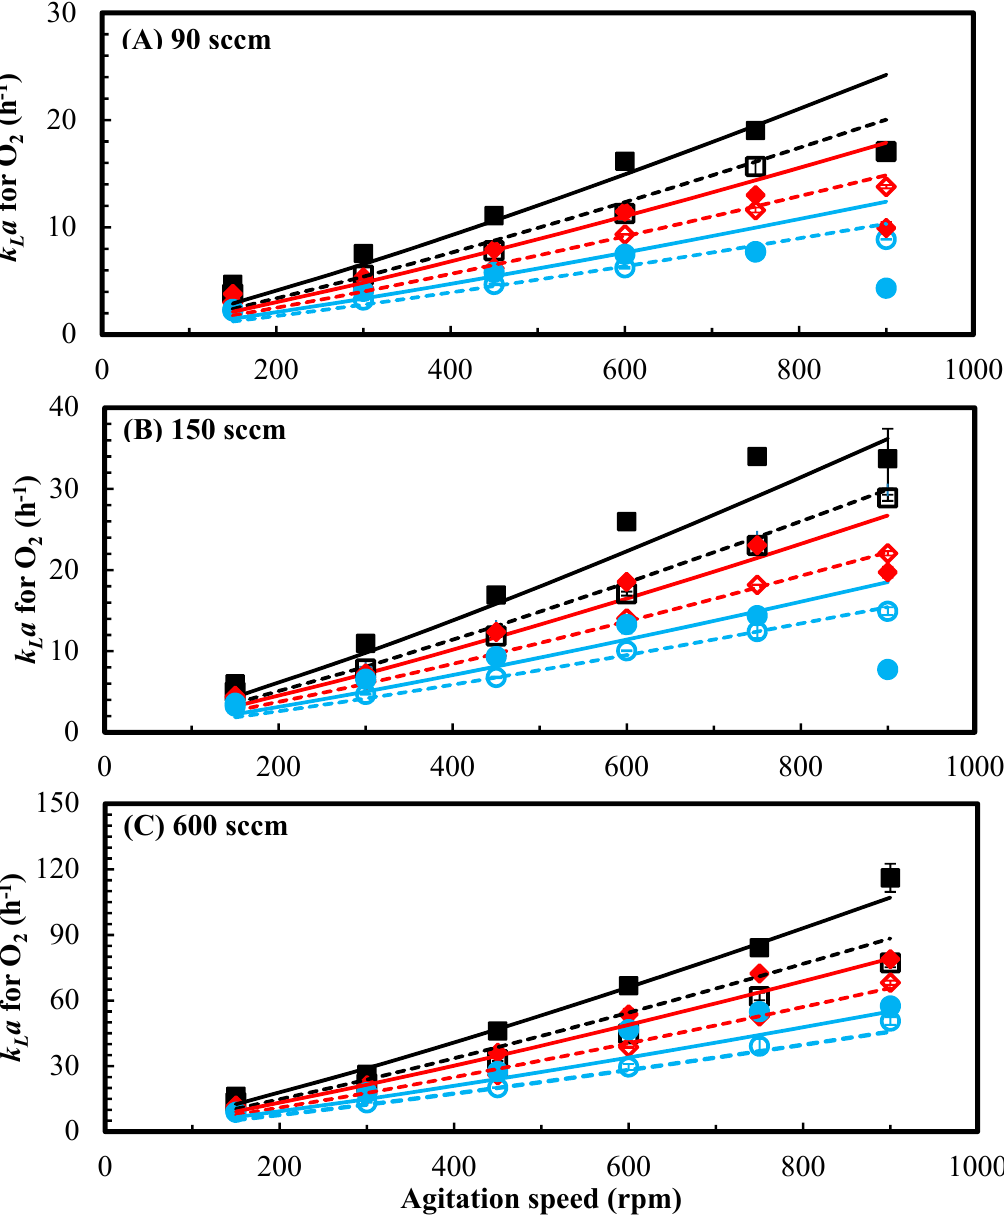
Figure 3. k L a for O 2 in air water system at standard flow rates in standard cubic centimeters per minute, sccm, ( A ) 90 sccm, ( B ) 150 sccm and ( C ) 600 sccm and headspace pressures of 101 kPa ( ■ ), 150 kPa ( ♦ ) and 240 kPa ( ● ) in 3 L (experimental data in solid symbols, model predictions in solid lines) and 5.6 L (experimental data in open symbols, model predictions in dash lines) working volumes. Error bars not visible are smaller than the symbols.